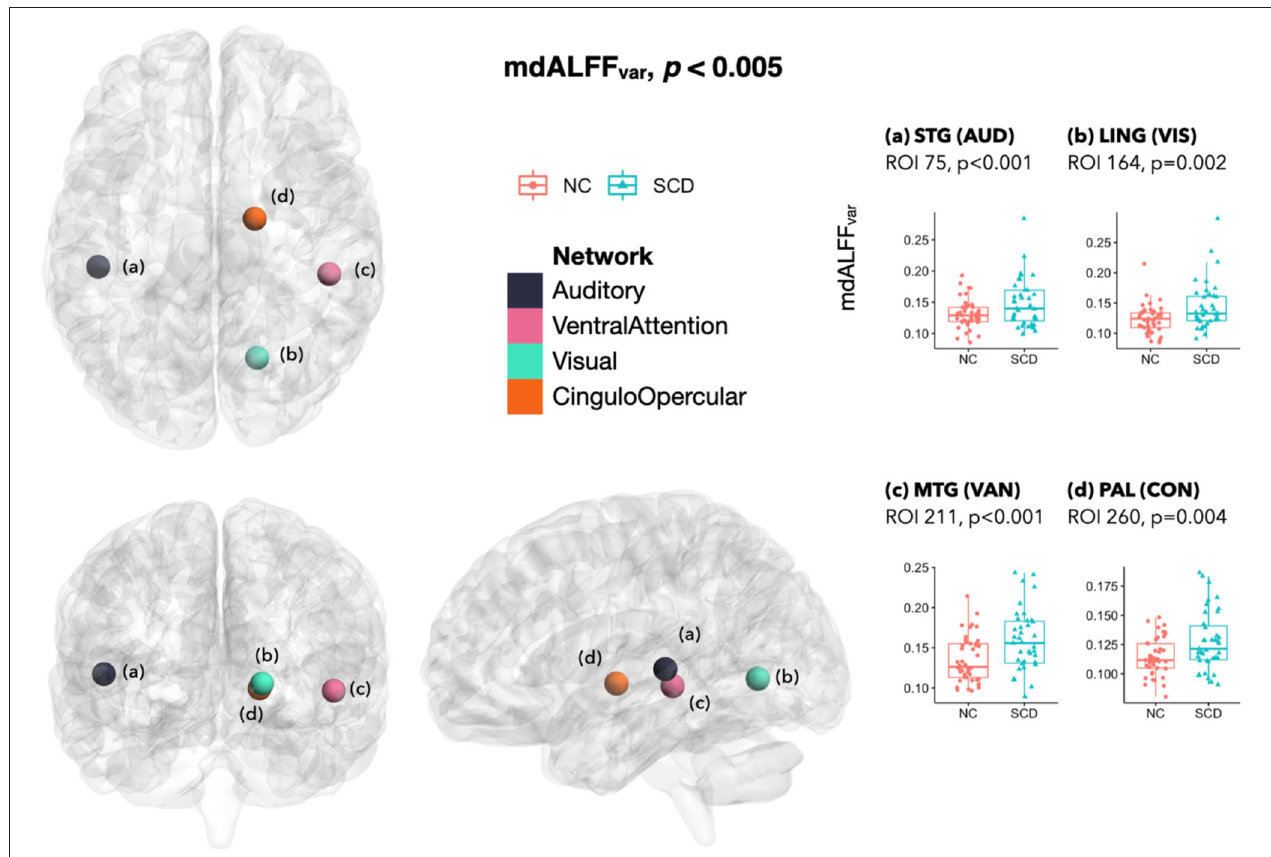
FIGURE 3 | Differences of mdALFF var between SCD and NC. The mdALFF var was higher in SCD than NC at ROI (A) in left STG of AUD, ROI (B) in right LING of VIS, ROI (C) in right MTG of VAN, and ROI (D) in right PAL of CON. In the SCD group, marginal changes of mdALFF var included an increase at a VIS ROI in right CAL ( p = 0.005) and a decrease at a cFPN ROI in left Crus I ( p = 0.006) (not in the figure). mdALFF var , variance of the mean dynamic amplitude of low-frequency fluctuation; SCD, subjective cognitive decline; NC, normal control; ROI, region of interest; STG, superior temporal gyrus; AUD, auditory network; LING, lingual gyrus; VIS, visual network; MTG, middle temporal gyrus; VAN, ventral attention network; PAL, pallidum of lenticular nucleus; CON, cingulo-opercular network; CAL, calcarine fissure and surrounding primary visual cortex; cFPN, frontoparietal network in the cerebellar regions.